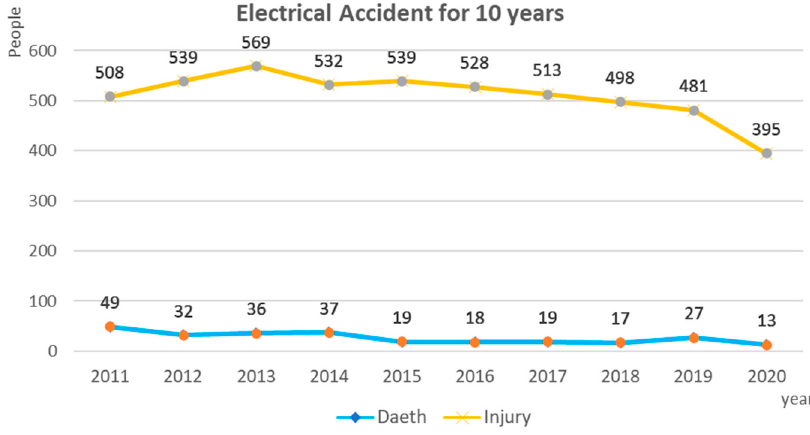
Figure 4. Statistics of electrical accidents over the last decade in South Korea (2011–2020).